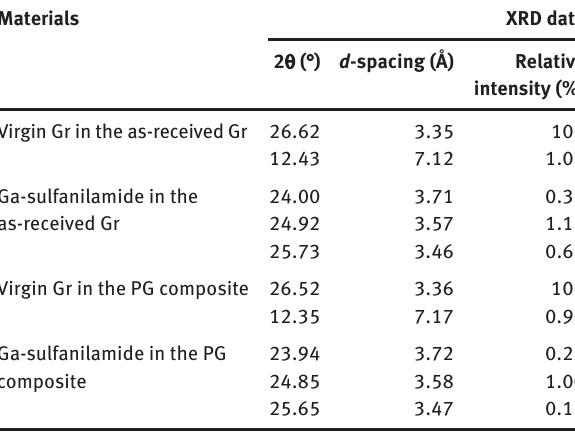
Table 1: XRD data of the as-received GR and PG